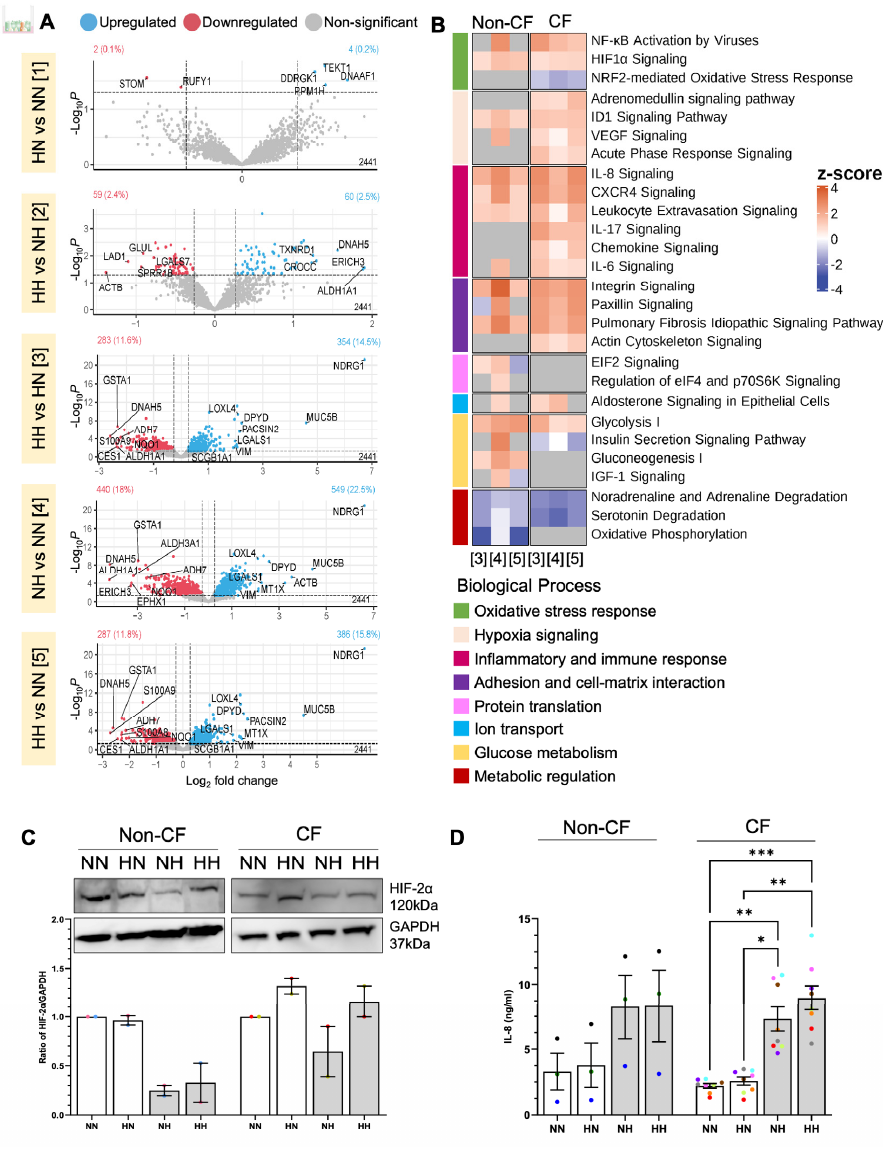
Figure 3. Effect of chronic hypoxia on the global proteome of differentiated human nasal epithelial cells (hNECs). ( A ) Volcano plots of differentially expressed proteins in each oxygen condition in differentiated ALI cultures from eight CF participants. Dotted lines indicate significance cut-off ( p –value ≤ 0.05, |fold change| ≥ 1.2). The count of significantly upregulated proteins, significantly downregulated proteins and total proteins are shown in top right, top left, and bottom right, re- spectively. The top 5 to 10 upregulated and downregulated proteins (determined based on logFC) are labelled. Comparisons are in pairs, [1] HN compared to NN; [2] HH compared to NH; [3] HH compared to HN; [4] NH compared to NN, and [5] HH compared to NN. ( B ) Heatmap of enriched canonical pathways of differentially expressed proteins determined by IPA. Color indicates the z- score for each pathway, with red (positive) indicating predicted activation, blue (negative) indicating predicted inhibition, and grey indicating no enrichment. The columns indicate comparison 3–5 as shown in ( A ). Comparisons 1 and 2 did not result in significantly enriched pathways. Data in ( A ) and ( B ) were derived from 3 non–CF and 8 CF participants. ( C ) Western blot of hypoxia–inducible factor 2 alpha (HIF–2 α ) from 2 non–CF and 2 CF participants. ( D ) IL–8 ELISA of the culture supernatants of ALI cultures at days 21–25. Each colored circle represents cultures of an individual participant. Data are presented as bar plots with mean ± standard error of the mean (SEM). One-way ANOVA was used to determine statistical significance. * p < 0.05, ** p < 0.01, *** p <